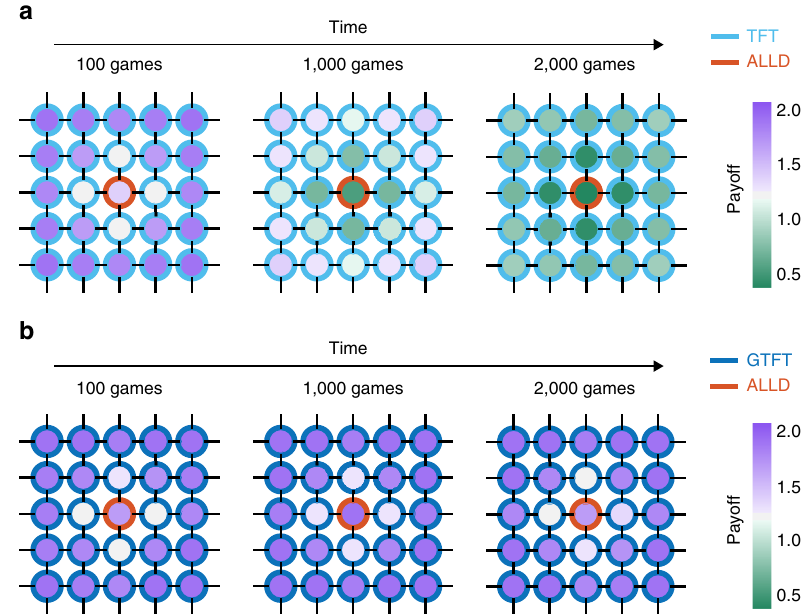
Fig. 2 Cooperative and defective behavior can spread across a population in the presence of crosstalk. Twenty-four conditional cooperators (blue framed nodes, panels) and one ALLD (Always-Defect) player (red framed node, placed in the center) populate a 5 × 5 lattice. The fi ll color of the nodes depicts the expected payoff of the players after 100, 1000, and 2000 games. a If the conditional cooperators use TFT (Tit-for-Tat), crosstalk leads to the spread of defection from the ALLD player to all other group members. Cooperation goes extinct. b GTFT (Generous Tit-for-Tat) is an error-correcting strategy and can thereby suppress the spread of defection by crosstalk. Only the players in the neighborhood of the ALLD player have reduced payoff. Parameter values: crosstalk rate γ = 0.5, bene fi t b = 3, and cost c = 1. For GTFT (de fi ned by p = 1 and 0 < q < 1), we used q =